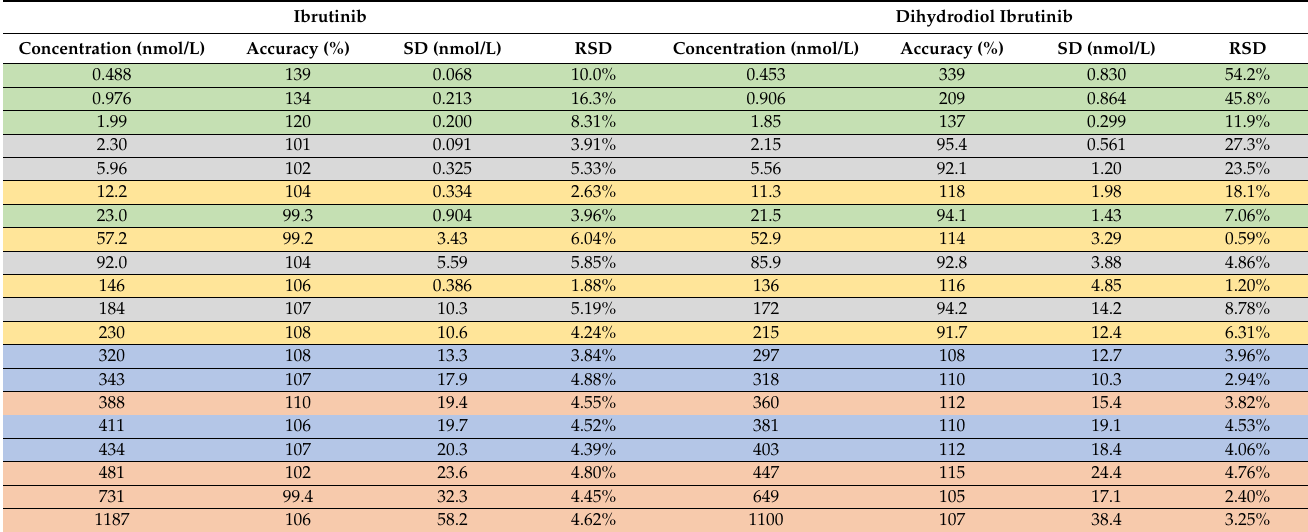
Table 2. Performance of the assay method. The analytes were spiked to 20 independent human plasma samples at each concentration level. Experiments were conducted on five different days, indicated by different colors. N/D, not determined. RSD, relative standard deviation. SD, standard deviation. Experiments performed on different days are shown in different colors.